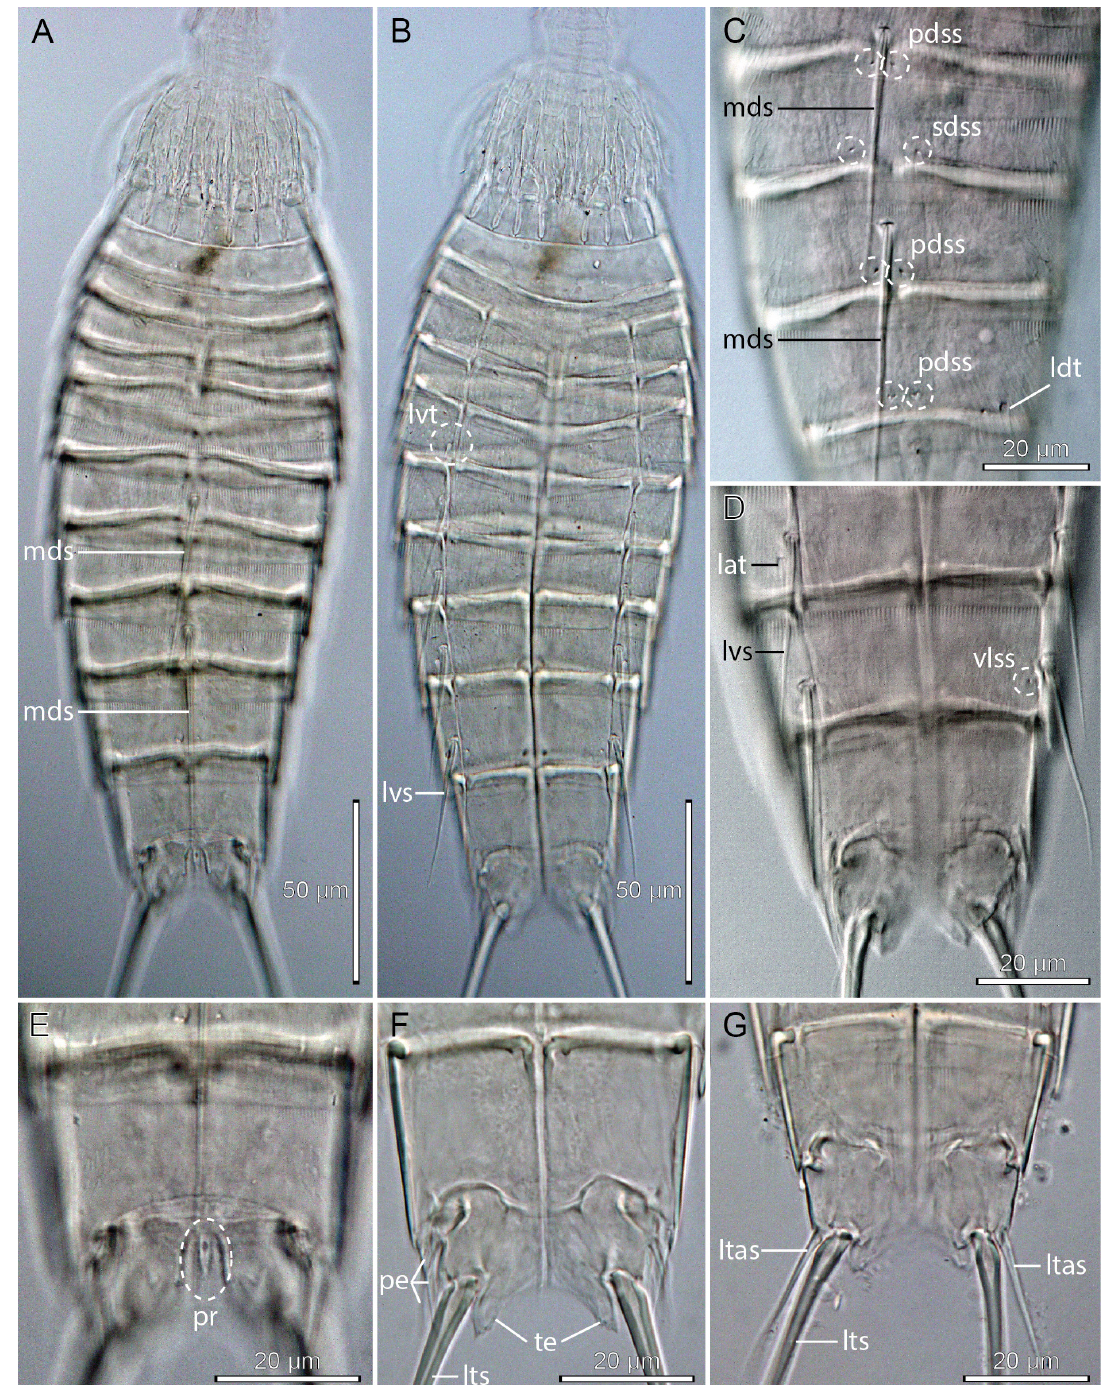
Fig. 12. Light micrographs showing overviews and details of Echinoderes hviidarum sp. nov., holotype, ♂ (A–B, E–F) (NHMD-213610), paratype, ♂ (C–D) (NHMD-213614) and paratype, ♀ (G) (NHMD- 213635). A . Dorsal overview. B . Ventral overview. C . Segments 6 to 9, dorsal view. D . Segments 8 to 11, ventral view. E . ♂, segments 10 to 11, dorsal view. F . ♂, segments 10 to 11, ventral view. G . ♀, segments 10 to 11, ventral view. Abbreviations: lat = lateral accessory tube; ldt = laterodorsal tube; ltas = lateral terminal accessory spine; lts = lateral terminal spine; lvs = lateroventral spine; lvt = lateroventral tube; mds = middorsal spine; pdss = paradorsal sensory spot; pe = penile spines; pr = protuberance; sdss = subdorsal sensory spot; te = tergal extensions; vlss = ventrolateral sensory spot.